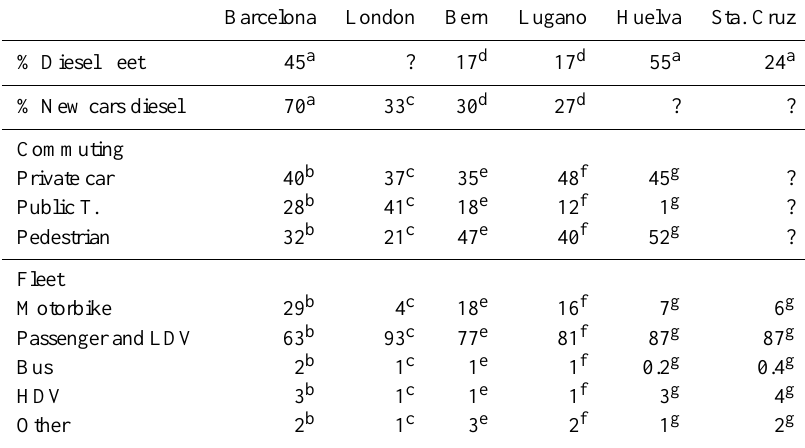
Table 1. Features of fleets and commuting of the 6 selected cities.